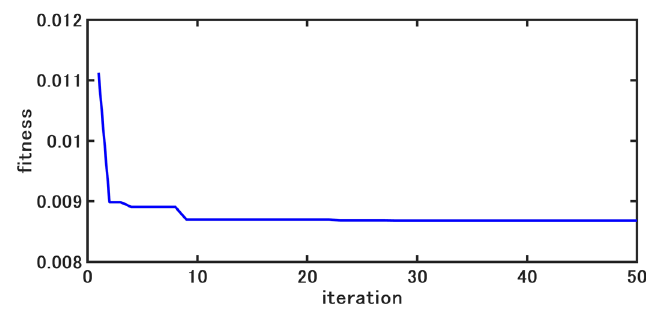
Figure 9. Current of BJDST Driving Condition.